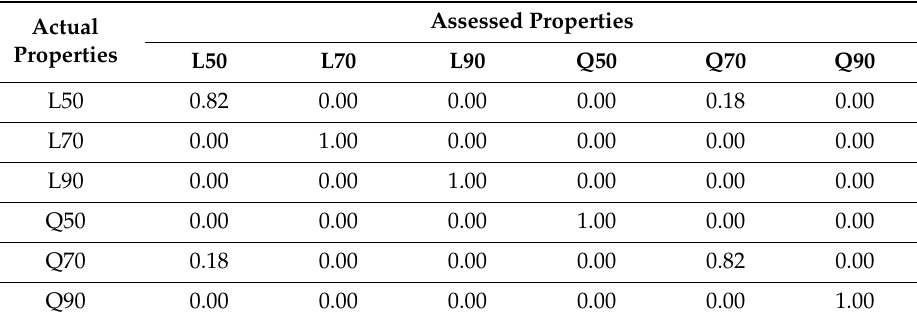
Table 3. Confusion matrix for foundation property test.